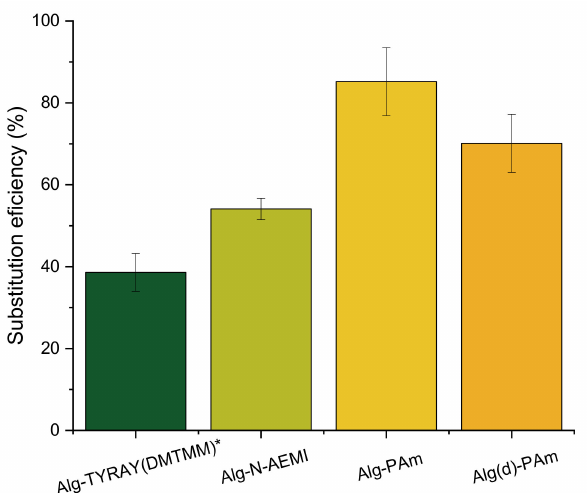
Figure 4. Substitution efficiency of the amidation with DMTMM. All values are reported as mean with the standard deviation ( n = 3).